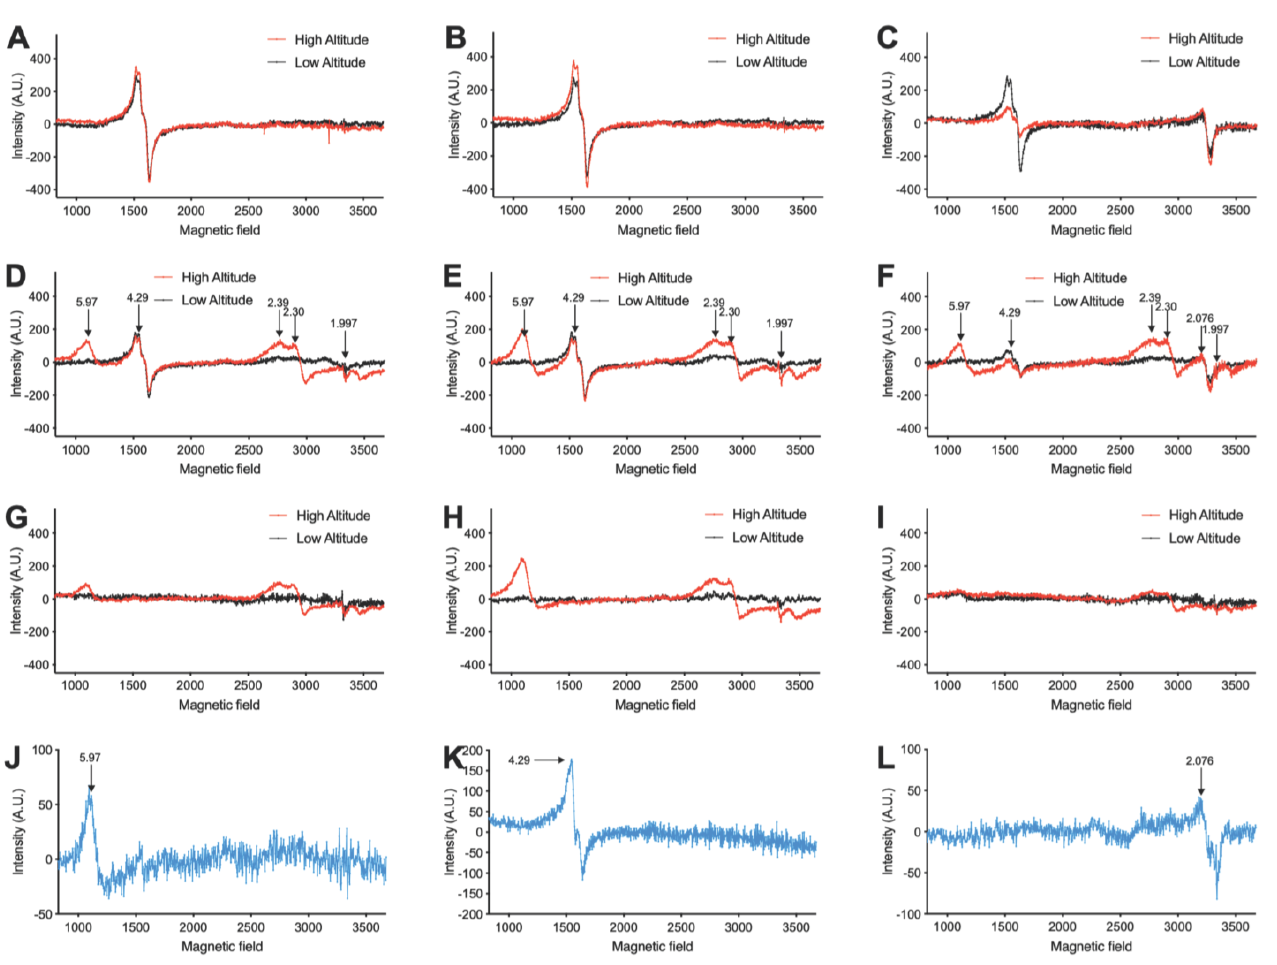
Figure 1. Representative EPR spectrum of blood from high- and low-altitude pregnant sheep.